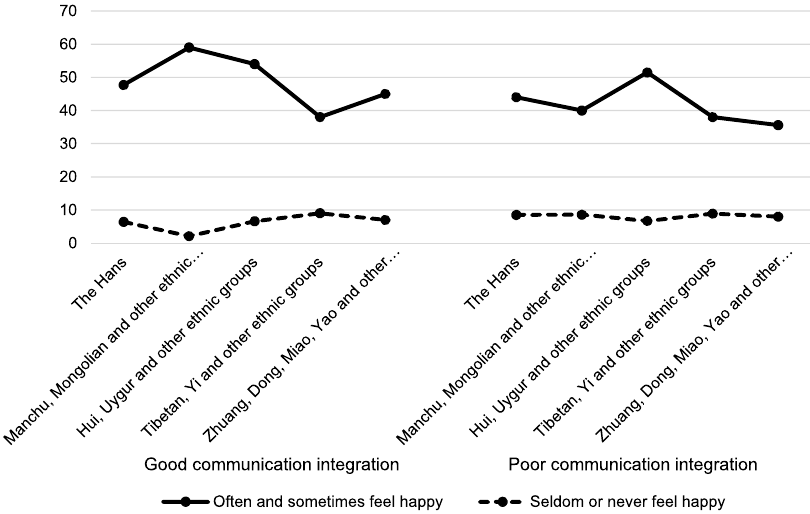
Fig. 7 Integration through communication and subjective well-being of ethnic groups